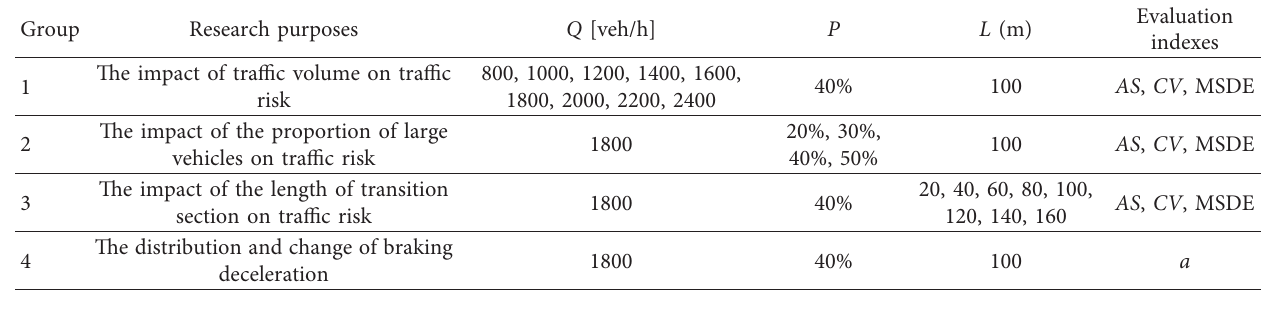
Table 2: Simulation experiment design.